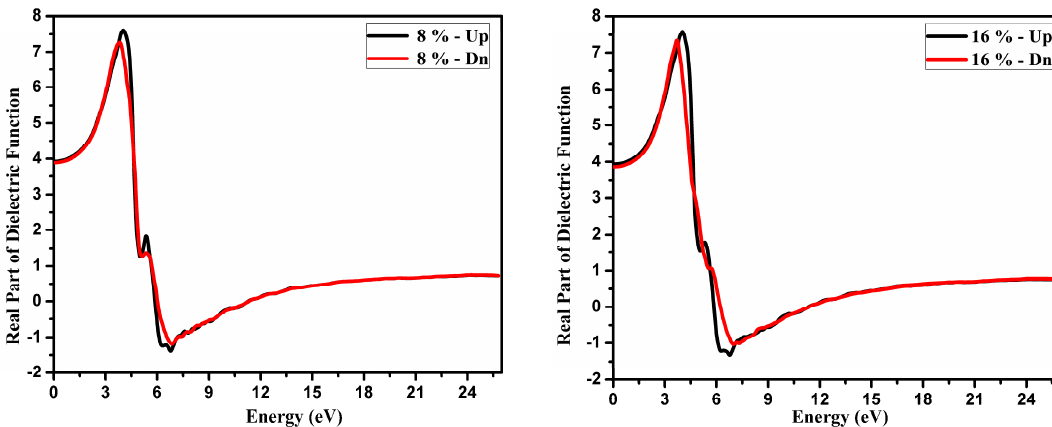
Figure 6. Calculated real part dispersion (dark solid curve ‐ black color for up spin) and (long solid curve ‐ red color for down) spectra of Mn x Zn 1 − x Te (x = 8% and 16%).